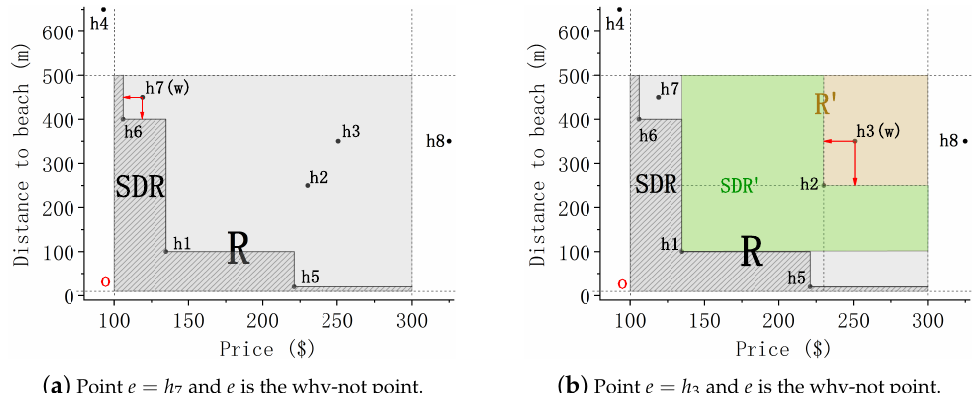
Figure 5. Two examples of the MWR